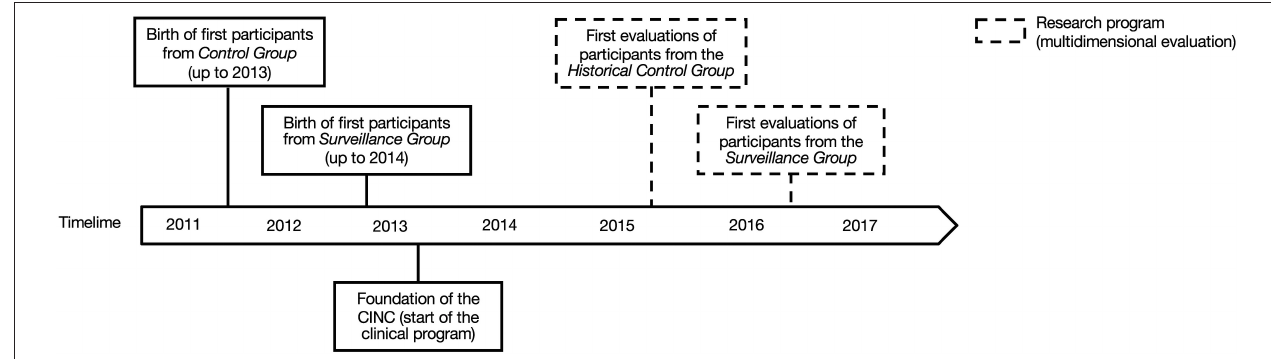
FIGURE 2 | Timeline of participants’ births (plain lines) and research assessments (dotted lines) for the Historical Control Group and the Surveillance Group .